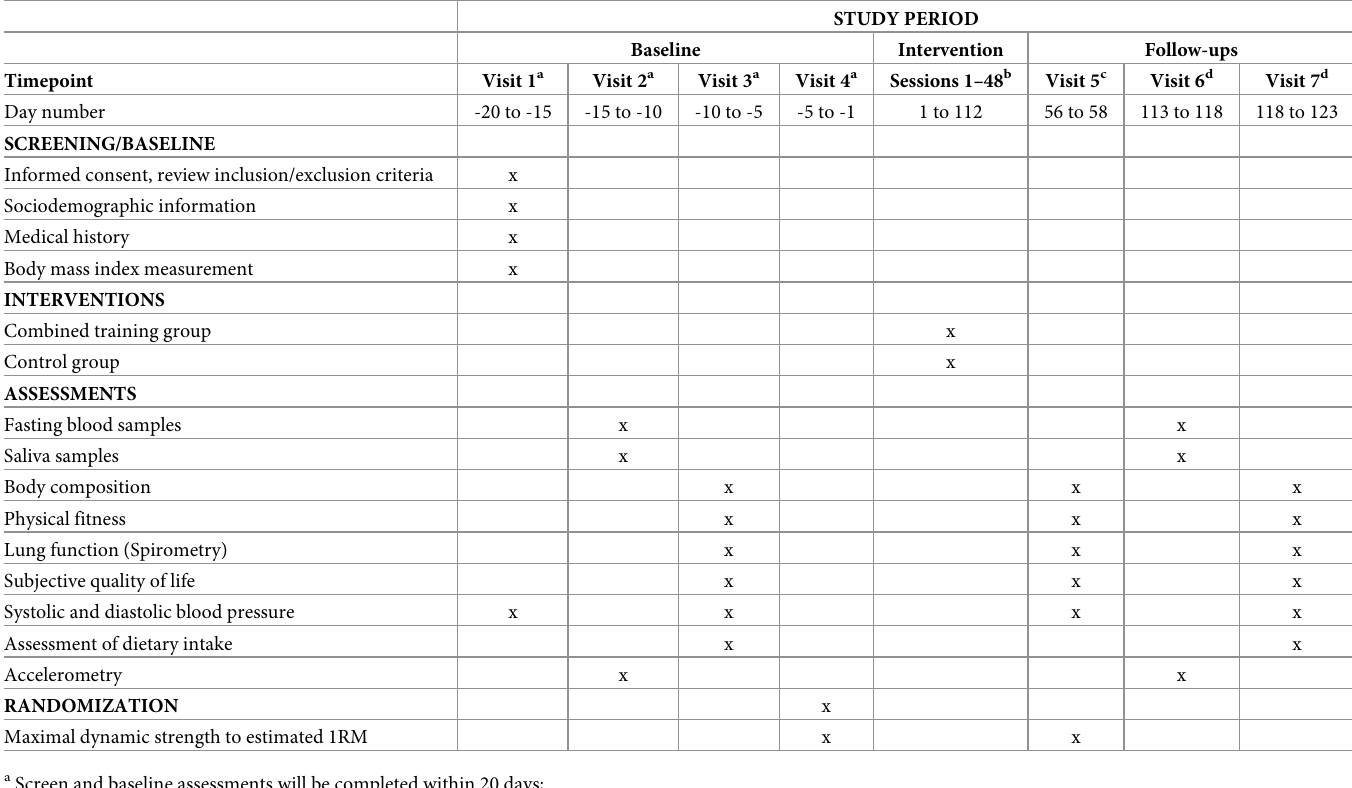
Table 3. Schedule of enrolment, interventions, and assessments.